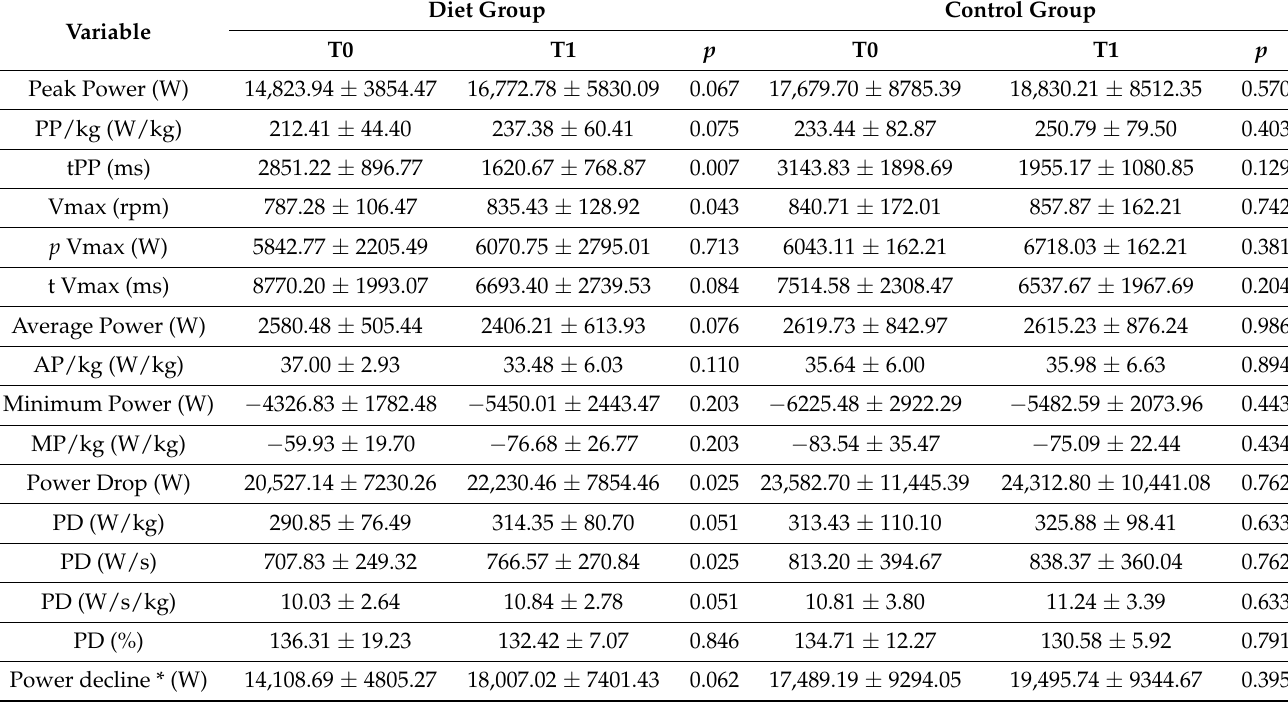
Table 3. Results of the Wingate